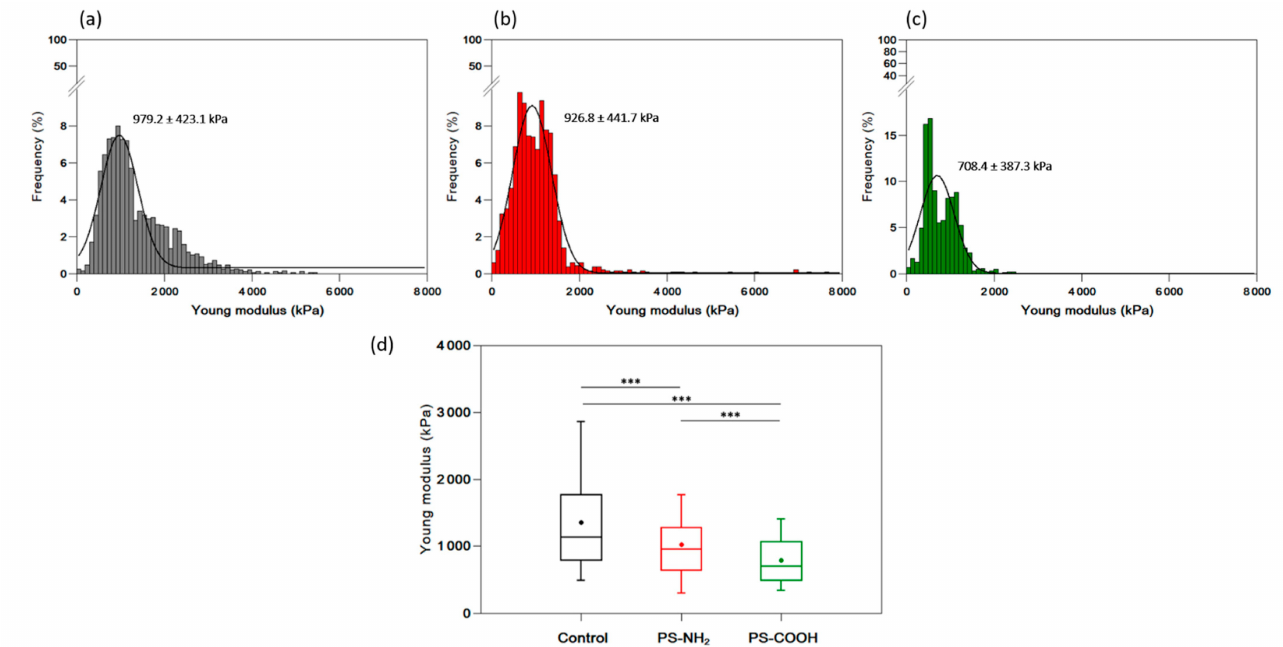
Figure 7. Nanomechanical characterization of Cylindrotheca closterium exposed to PS-NH 2 and PS- COOH nanoplastics. Histograms showing the distribution of Y m values of C. closterium cells in the exponential growth phase (day 7) in control culture ( a ), in the culture exposed to PS-NH 2 NPs (5.0 µ g mL − 1 ) ( b ), and in the culture exposed to PS-COOH NPs (200 µ g mL − 1 ) ( c ), on 5 cells for each culture (all values are presented in the Supplementary Material, Table S2). Boxplots show the distribu- tion of Y m values recorded in each case ( d ). A box with whiskers represents a median ± interquartile range (Q3–Q1). Statistical significance was obtained from an unpaired t -test at the level of 0.001 (*** p <